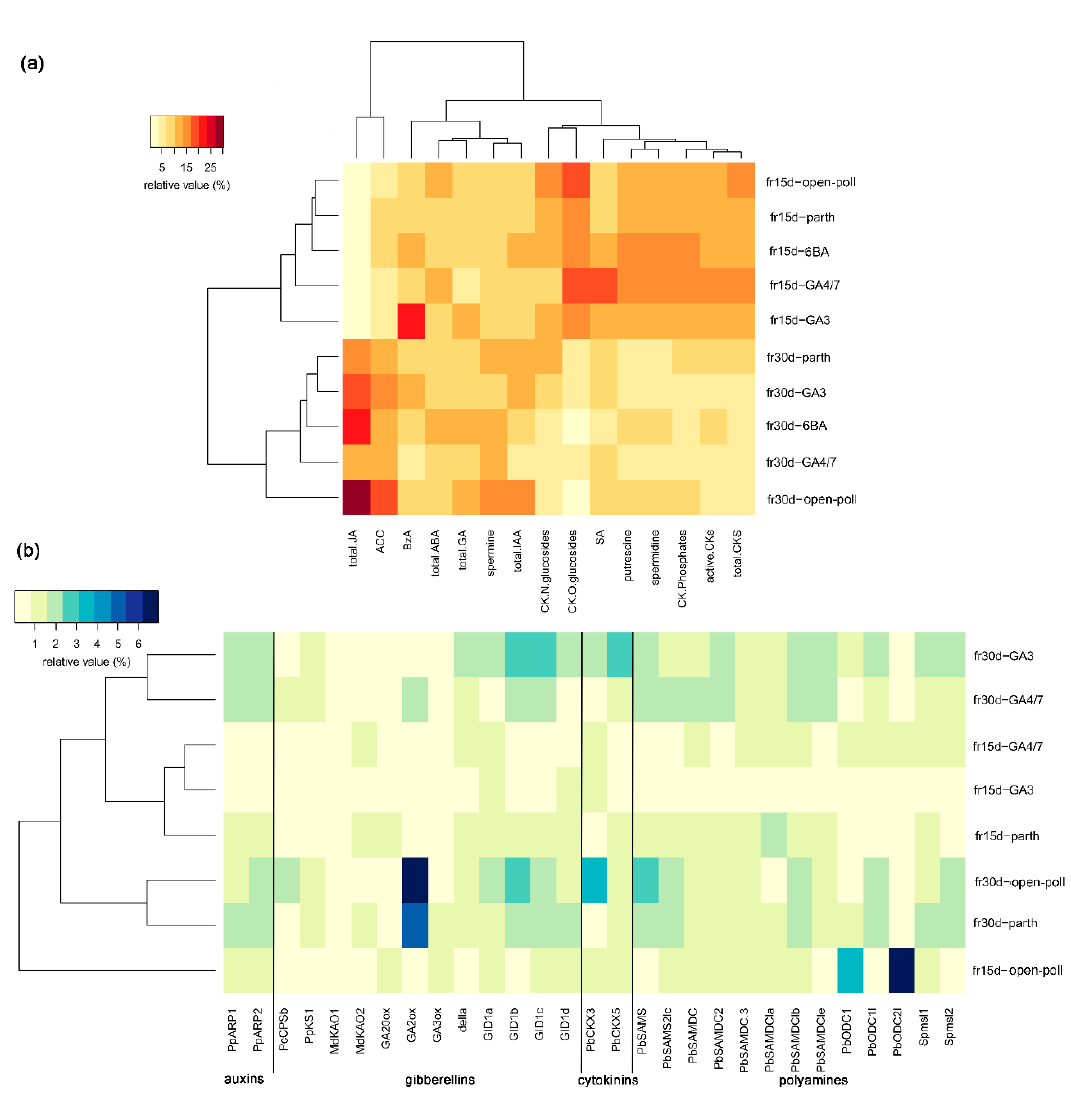
Figure 4. Effects of extrinsic parthenocarpy on hormonal regulation during early fruit development of ‘Conference’ pear fruits. ( a ) Heatmap of phytohormone and polyamine profiles in young ‘Conference’ fruits after different hormonal treatments; relative distribution expressed in %. ( b ) Heatmap of relative transcript levels of genes involved in phytohormone and polyamine metabolism and signaling in ‘Conference’ young fruits after different hormonal treatments. Fifteen-day-old fruit (fr15d) and 30-day-old fruit (fr30d) after gibberellin (GA3, GA4/7) and cytokinin (6BA) treatments, self-pollination (parth), and open-pollination (open-poll). Phytohormone abbreviations are as described in Figures 1 and 2; gene annotations are as described in Table 1.